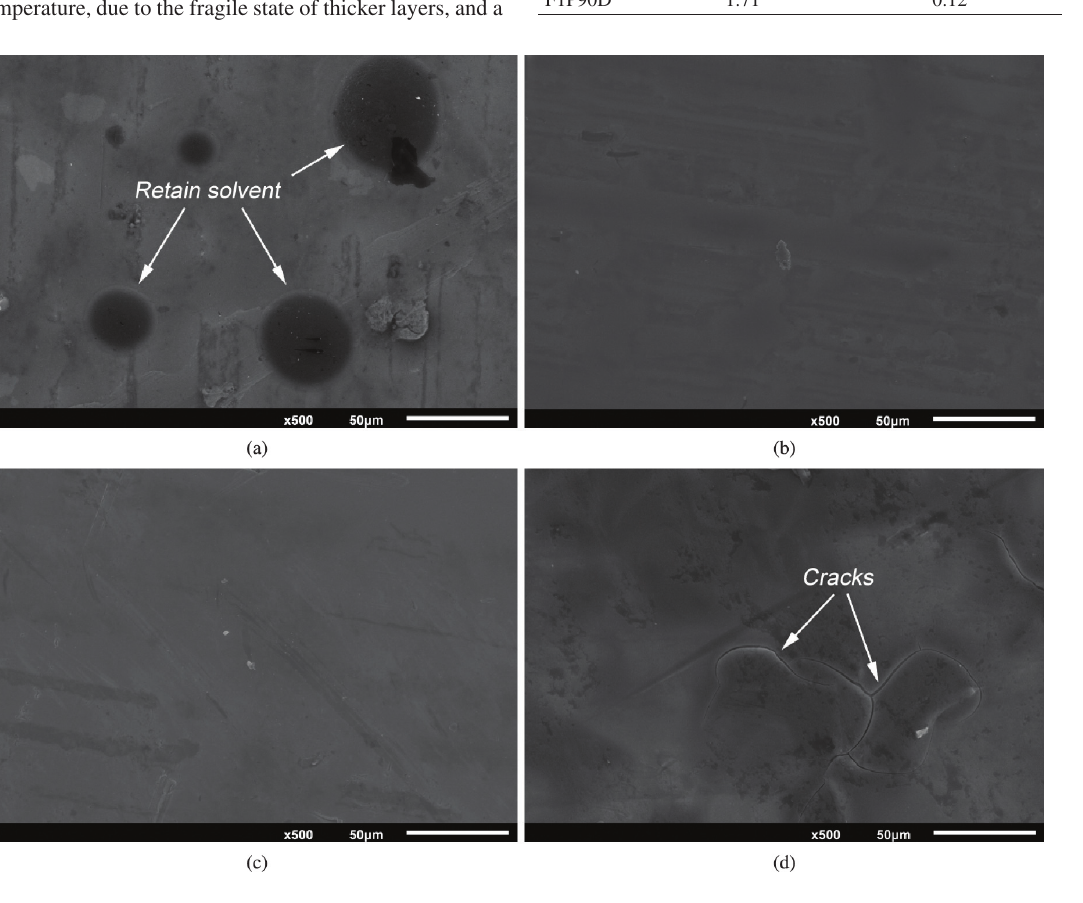
Figure 2. SEM micrographs obtained for the films: (a) F1P60M, (b) F1P60D, (c) F1P90M and (d) F1P90D.